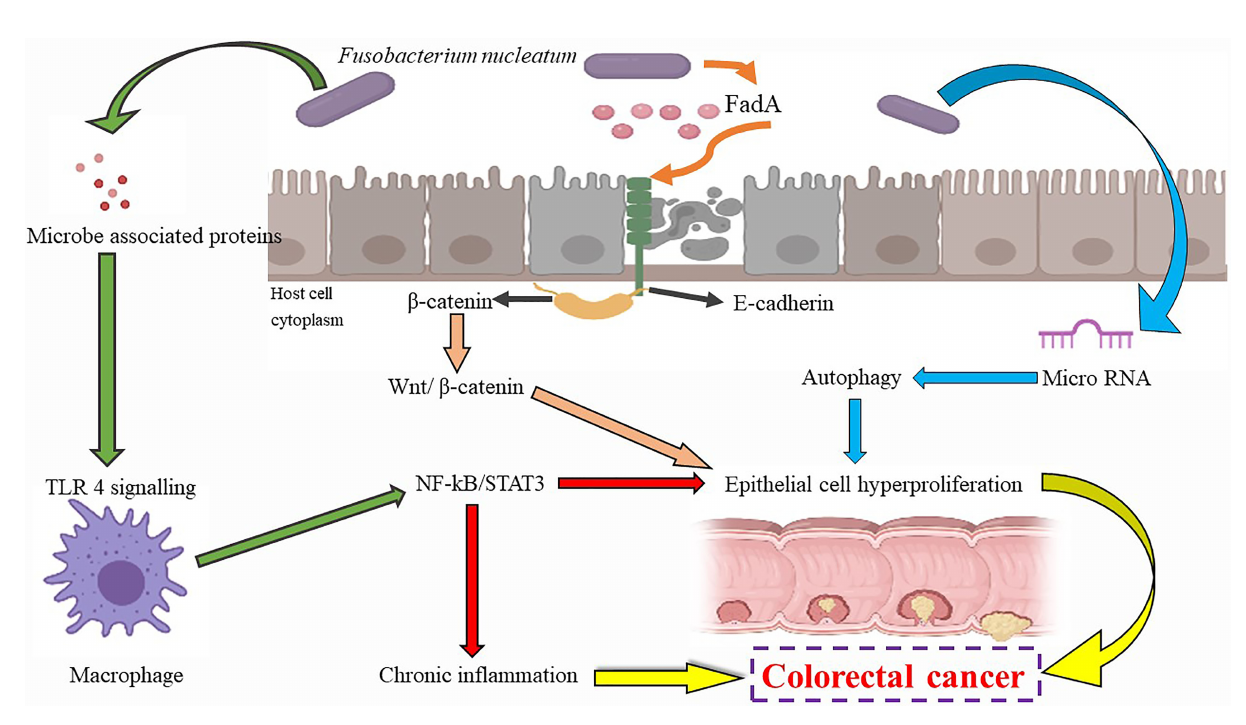
FIGURE 4 | Fusobacterium nucleatum and cancer